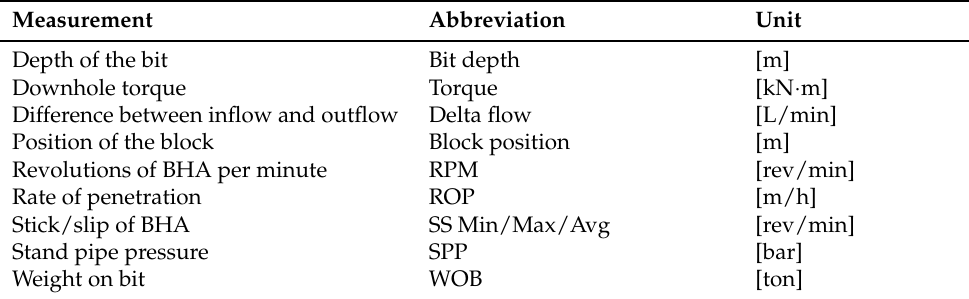
Table 1. List of measurements for real-time karst patterns’ detection.